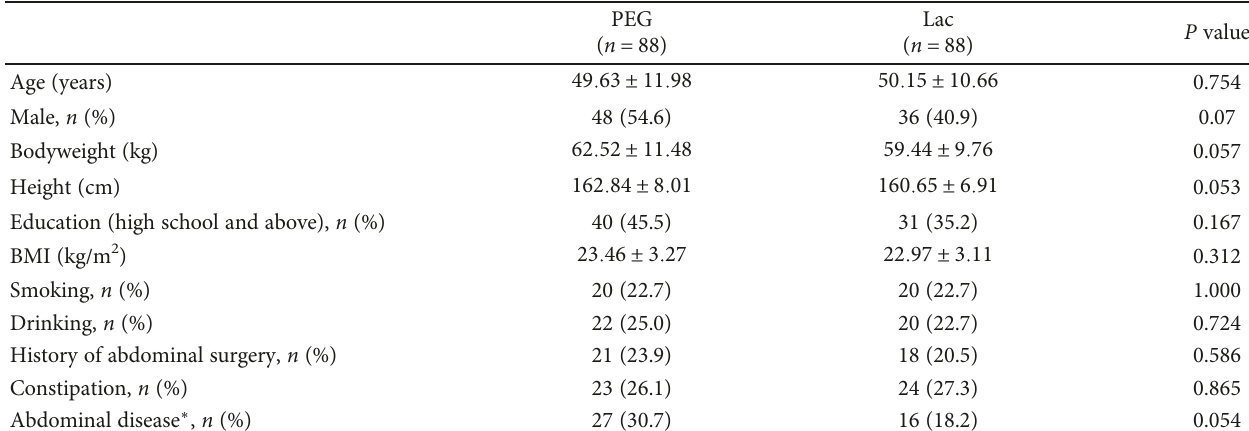
Table 2: Patient characteristics.